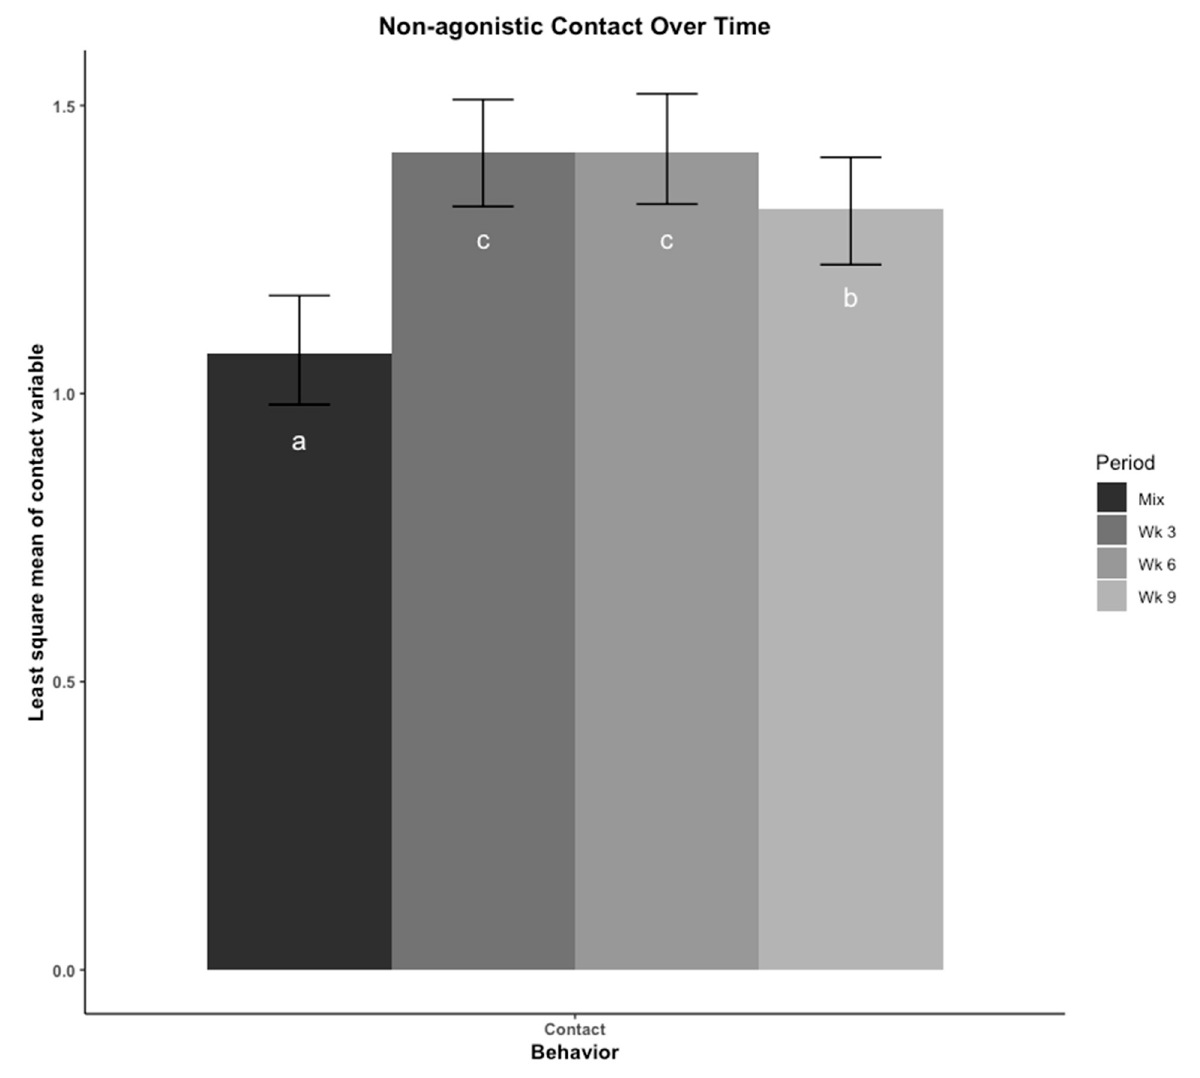
Figure 3. Non-agonistic contact was compared across four time points using least square means regression analysis. Pigs were observed for non-agonistic physical contact with conspecifics using scan-sampling every 10 min for 4 h. The contact variable was scored as the number of unique pigs the focal pig was in physical contact with without overt aggression occurring at each scan interval divided by the total number of scan intervals. The four time points are: immediately after mix, and 3, 6, 9 weeks (wk) after mix. Observations at 6 wk were made after pigs were moved to a new pen with their group. Errors bars represent the 95% confidence interval of the least square means. a–c: Bars with different letters denote time periods that showed different proportions of contact behavior ( p < 0.05, Tukey, HSD adjusted).